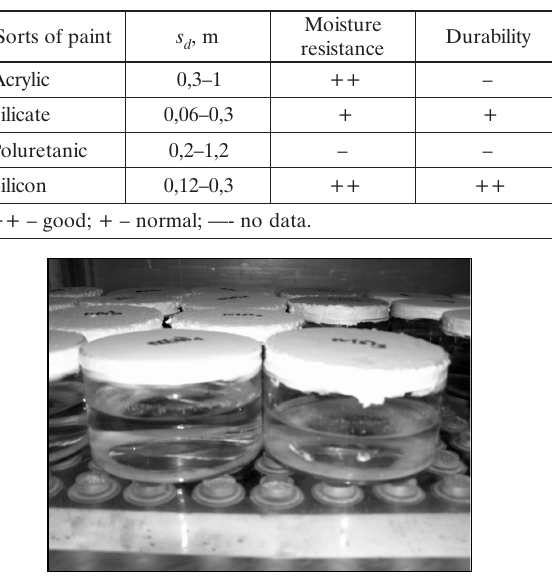
Table. 1 Paint properties and their dependence on the sort of paint